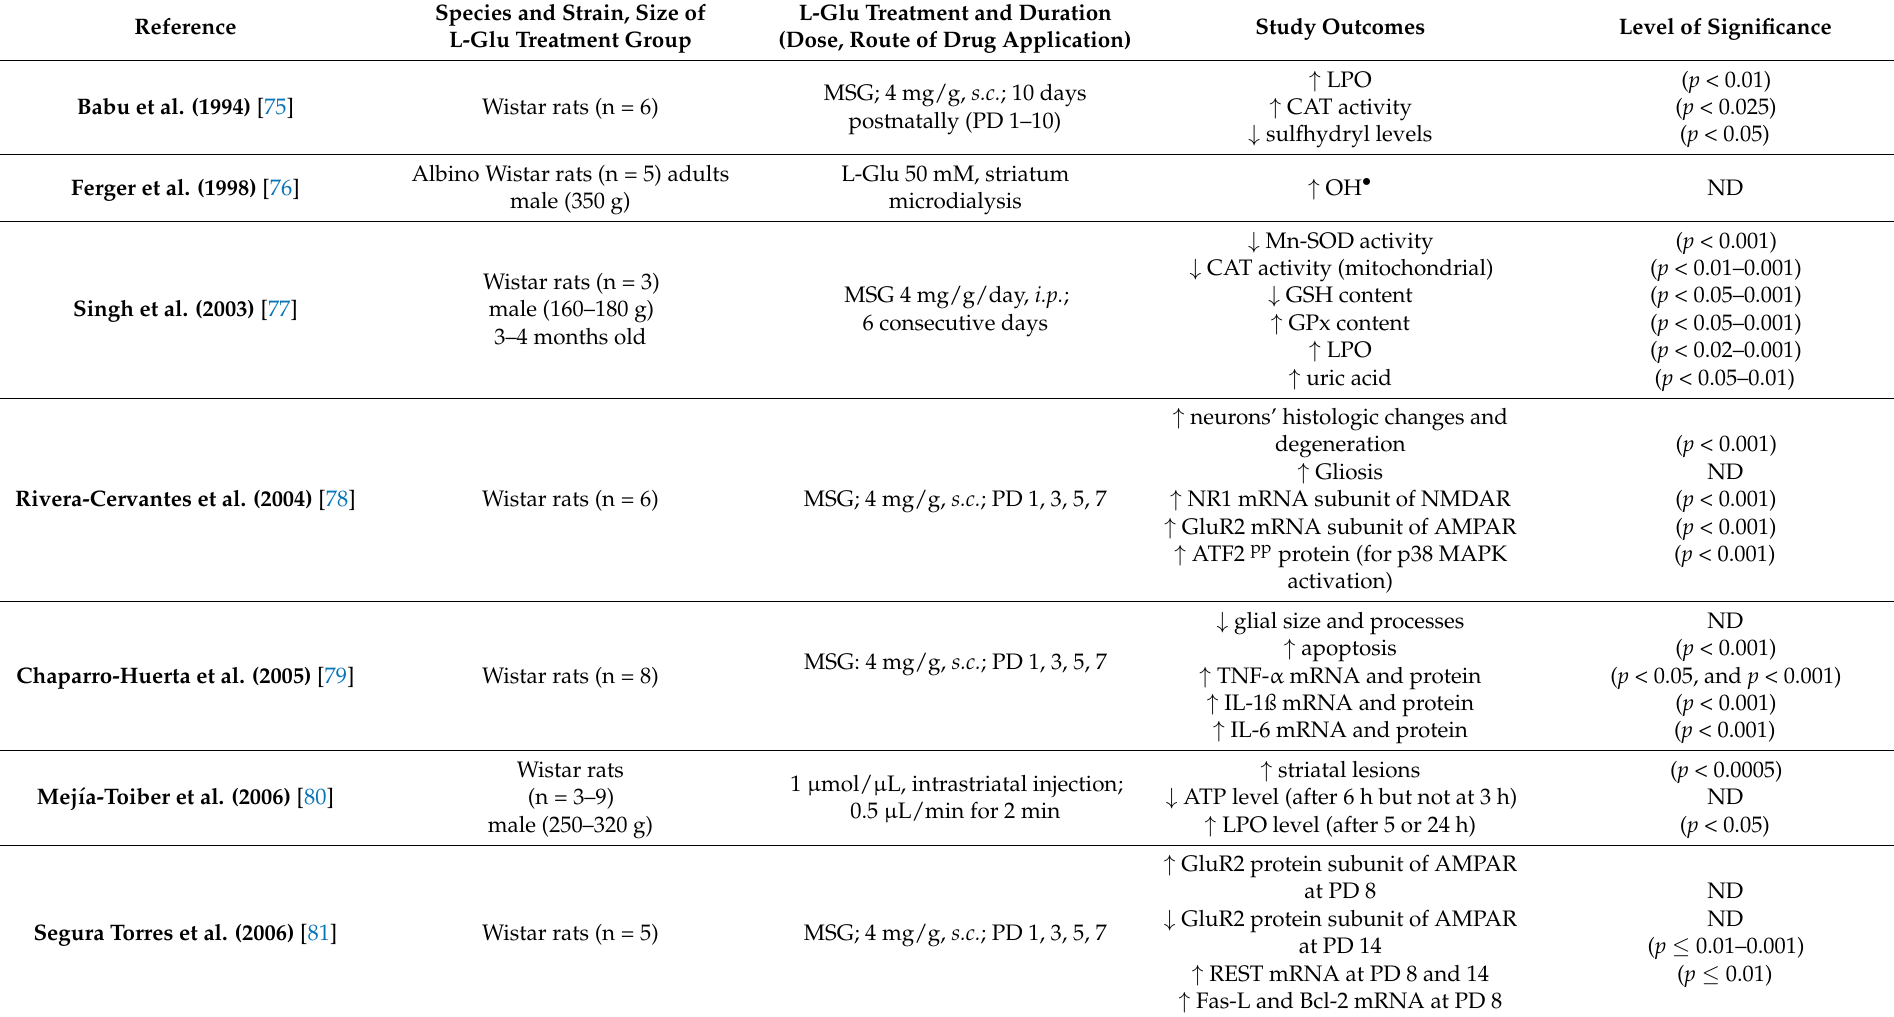
Table 2. L-glutamate in vivo studies’ outcome